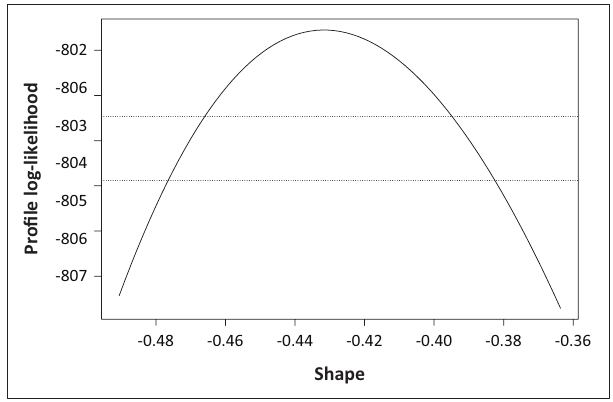
FIGURE 6-A1: Profile log-likelihood for the shape parameter γ using estimates of the model with r =